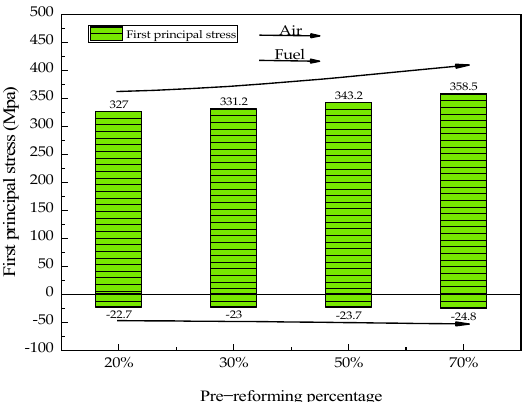
Figure 9. Variation range of the first principal stress under different methane Pre-Reforming per- centages.